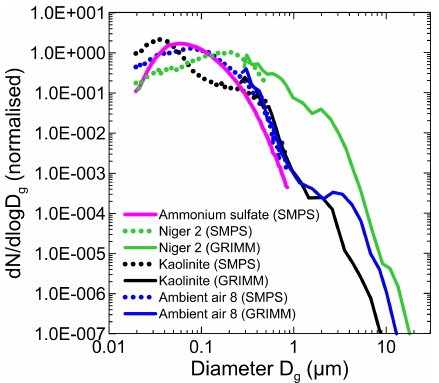
Figure 7. Examples of number size distribution (normalized to the total number concentration) for ammonium sulfate, dust (Niger sample), kaolinite, and ambient air aerosols. Data refer to the mean over each experiment as measured from the SMPS and the OPC. Error bars (standard deviations) have been omitted for the sake of